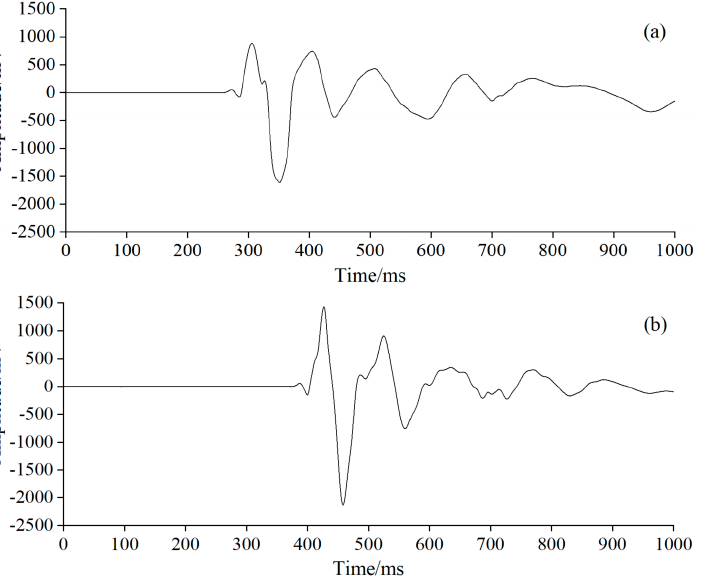
Figure 11. The time-domain waveform of AE by the PLB method: ( a ) Lead-breaking position is 50 mm; ( b ) lead-breaking position is 150 mm.